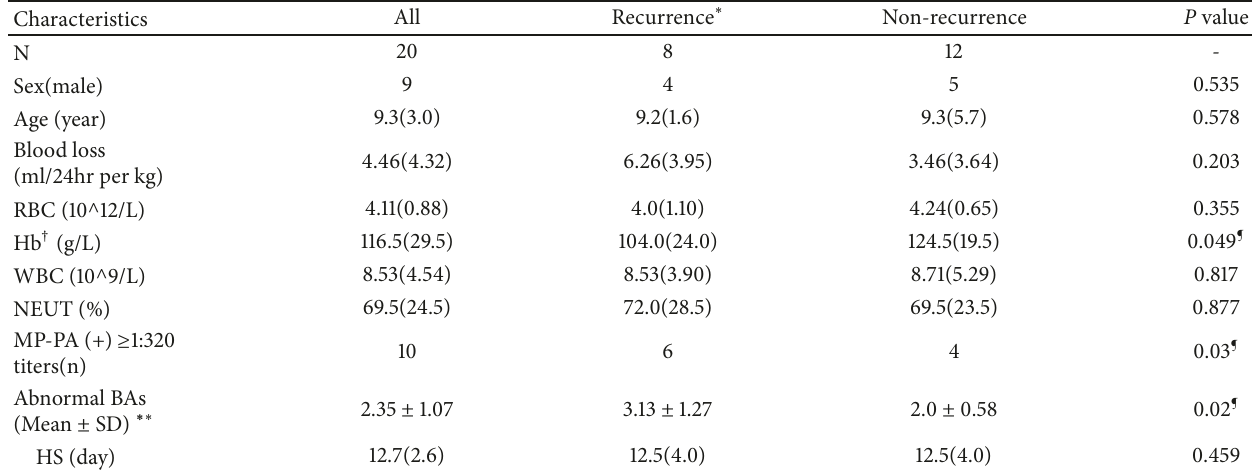
Table 1: Characteristics of enrolled cases between